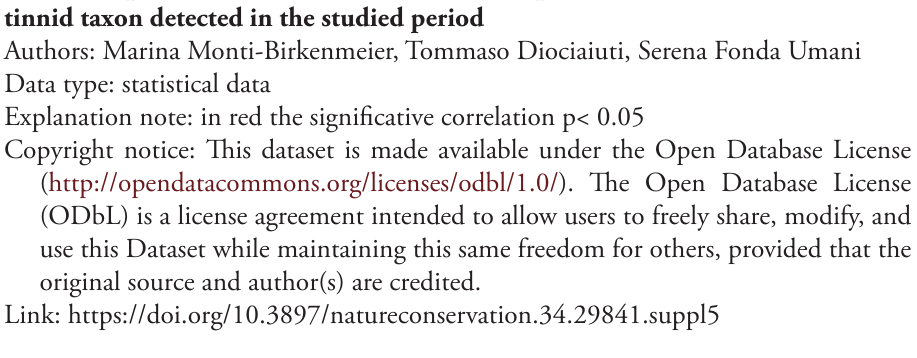
Table S5. Sperman’s correlation values with temperature and salinity for each tin- tinnid taxon detected in the studied